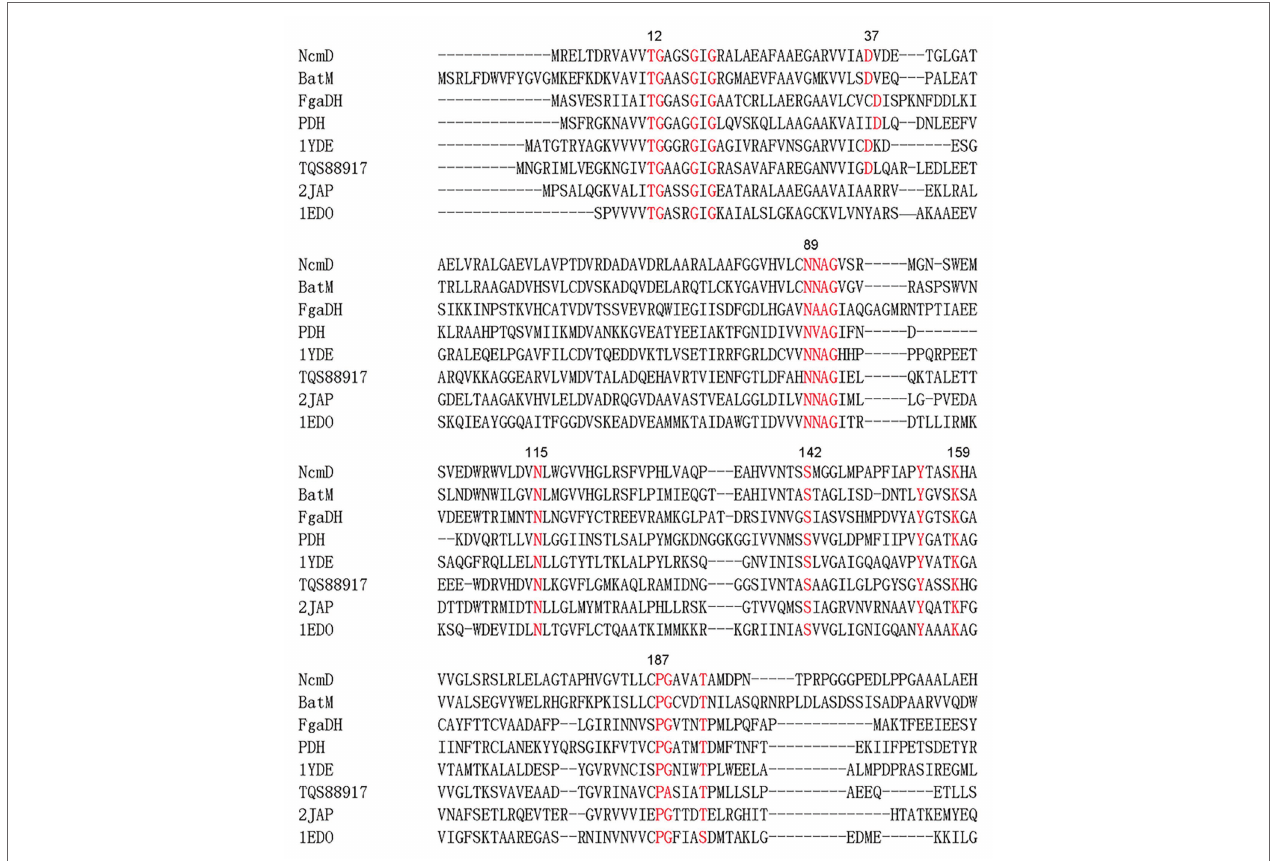
FIGURE 2 | Amino acid sequences alignment analysis of NcmD and its closely homologous proteins and characterized short-chain dehydrogenases/reductases (SDRs). BatM originated from Pseudomonas fluorescens BCCM_ID9359 shows 40% identity to NcmD. 2JAP (CAD) involved in clavulanic acid biosynthetic pathway originated from Streptomyces clavuligerus shows 31% identity to NcmD. FgaDH originated from Aspergillus fumigatus is a NAD + binding SDR. PDH originated from Drosophila melanogaster is a NAD + binding SDR. The ephedrine dehydrogenase TQS88917 originated from Arthrobacter sp. TS-15 is a NAD + binding SDR. 1YDE is a human retinal SDR using NADH as cofactor. 1EDO is a β -keto acyl carrier protein reductase from Brassica napus by using NADP + as